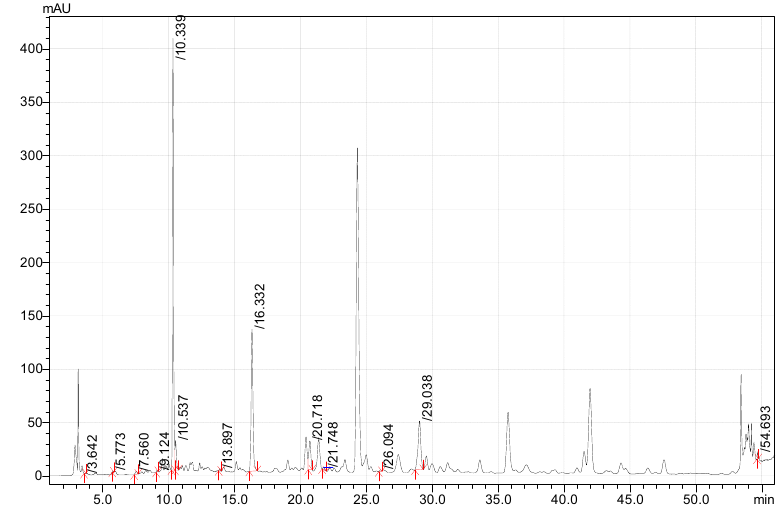
Figure 1. HPLC chromatogram of T. vulgare extract samples (Methanol–TFA). The HPLC chromatogram of the T. vulgare methanol extract with 0.1 N TFA is presented in Figure 1.